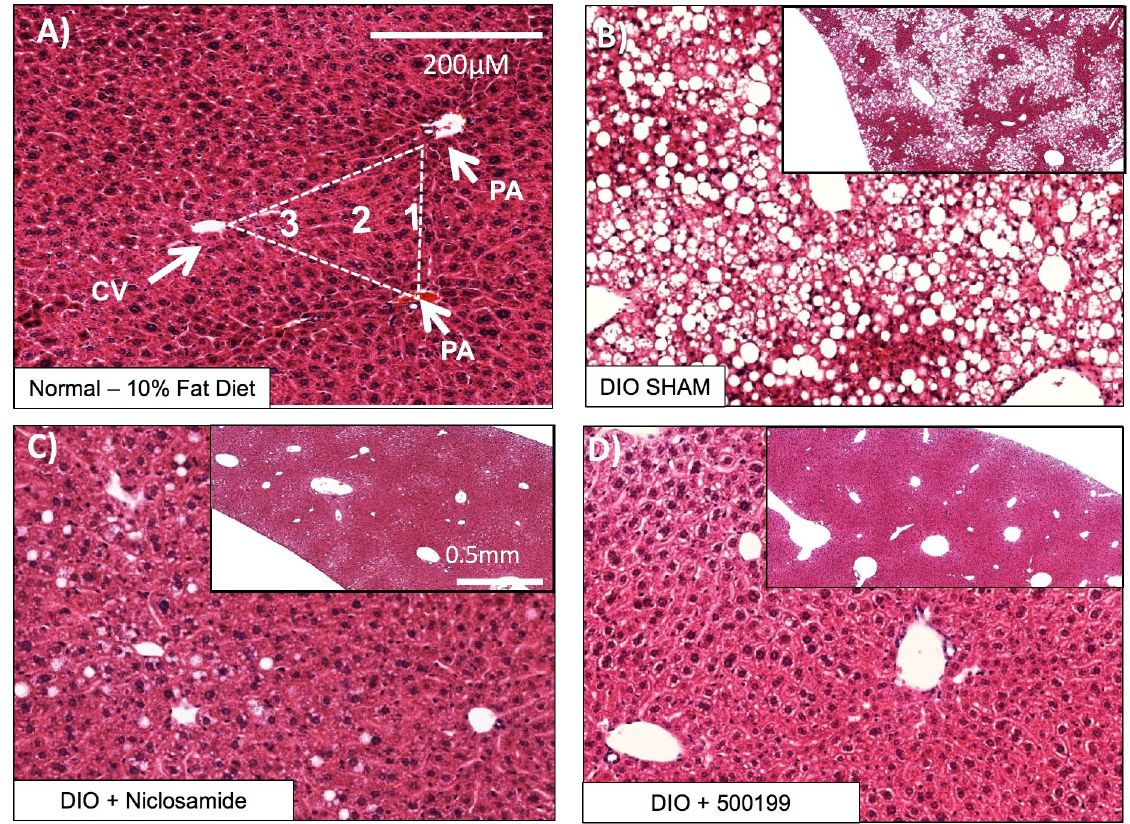
Fig 7. 500199 attenuates hepatic steatosis in high fat diet fed mice. 20-week old HFD-fed mice were delivered vehicle or compound daily via intraperitoneal injection for 12 days and compared to sham mice fed 10% fat diet. Representative images of H&E stained liver sections from 10% fat diet mice (A) 60% HFD-fed mice (B) or 60% HFD-fed mice treated with niclosamide (C) or 500199 (D) at 10mg/kg.